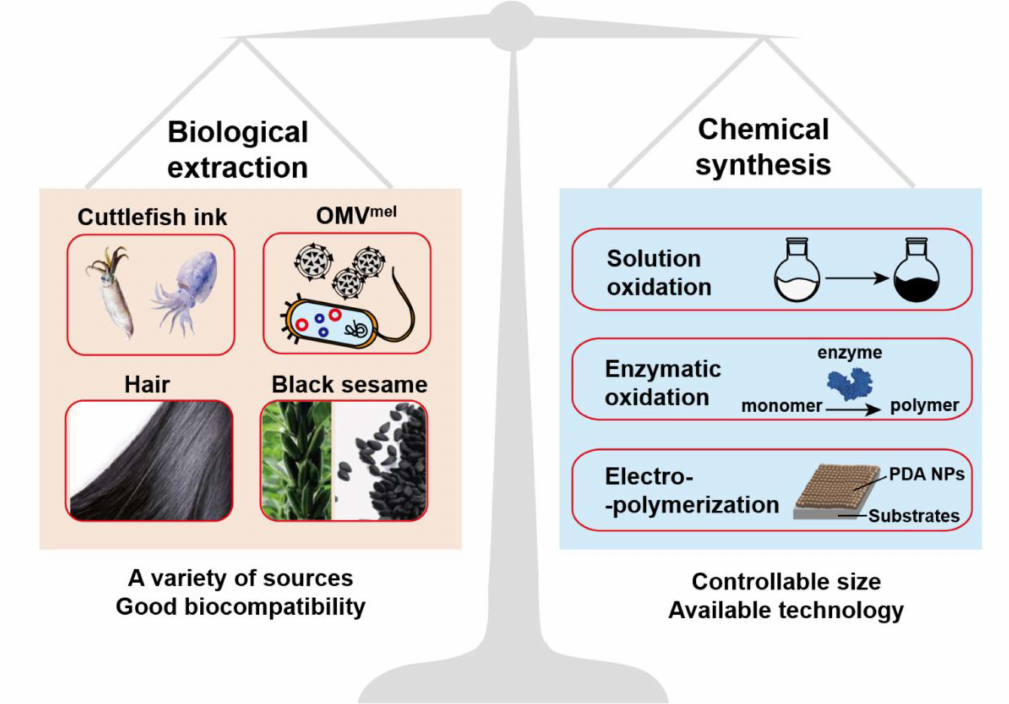
Figure 2. Schematic illustration of the synthesis method of melanin-like